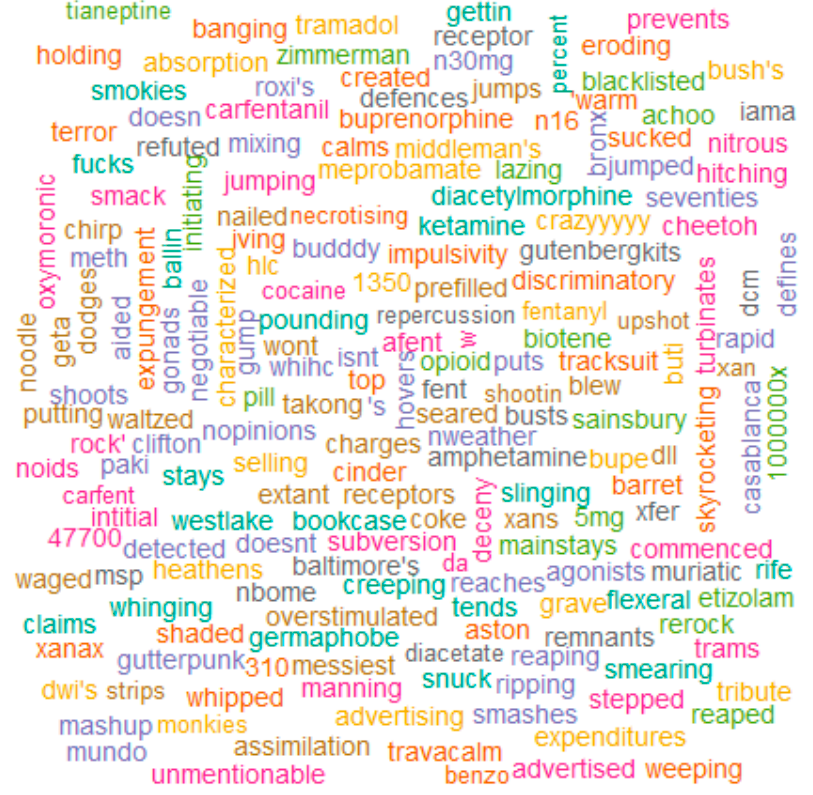
Figure 5. Decision values produced by a Linear SVM for author vectors trained with the /r/Opiates GloVe embedding, colored by subreddit of origin. A large magnitude of decision values corresponds to a large distance from the decision boundary of the SVM. The x-axis is an arbitrary user ID assigned to an author vector from /r/CasualConversation (left) or /r/Opiates (right).